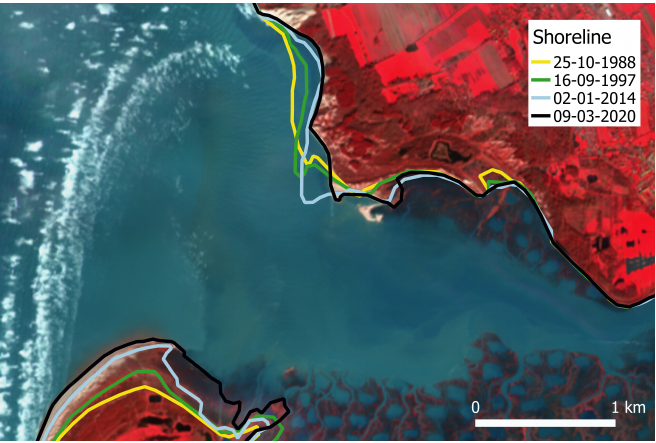
Figure 9. Shoreline evolution of the Authie Bay from 1988 to 2020. Background: Sentinel-2 false-color composite